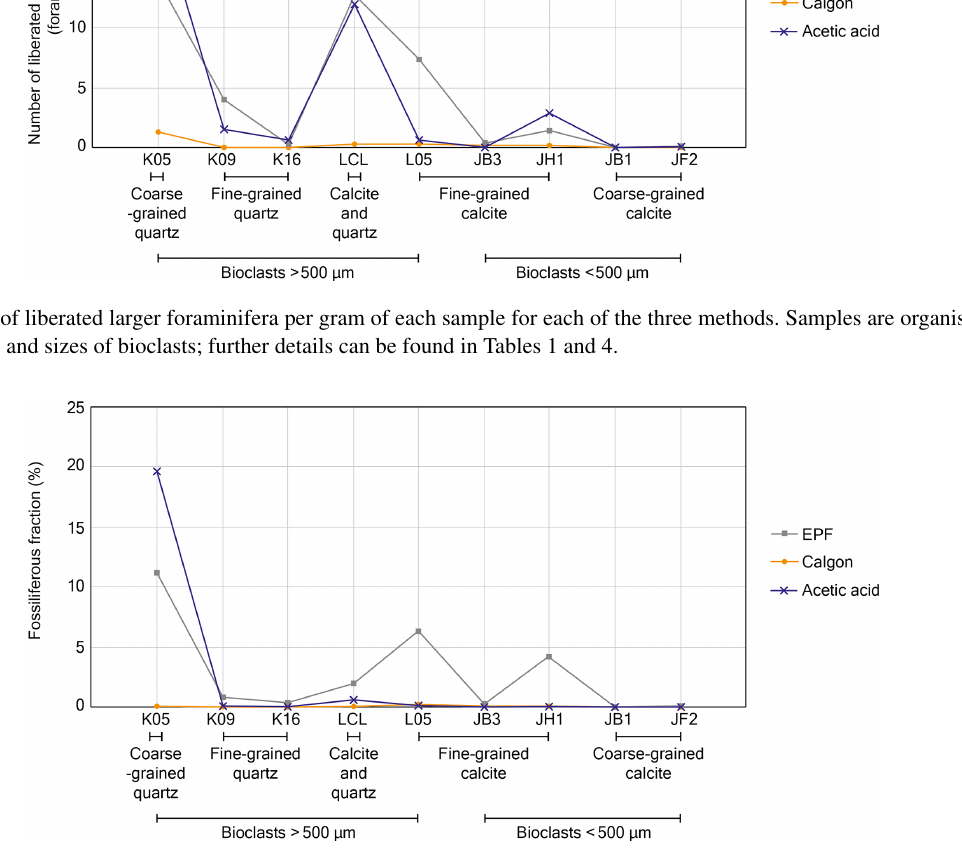
Figure 6. Percentage fossiliferous fraction ( > 63µm) for each sample from the three different methods. Samples are organised into types of infilling cements and sizes of bioclasts; further details can be found in Tables 1 and